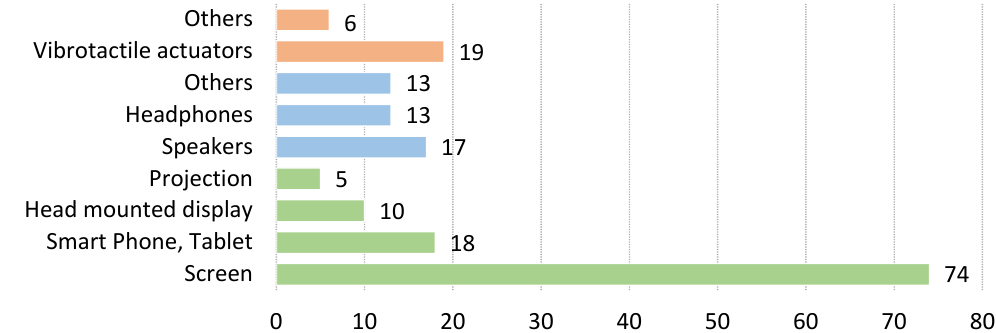
Figure 12. Feedback device usage according to different feedback modalities. Visual feedback devices are represented in green, auditory in blue and haptic in orange.